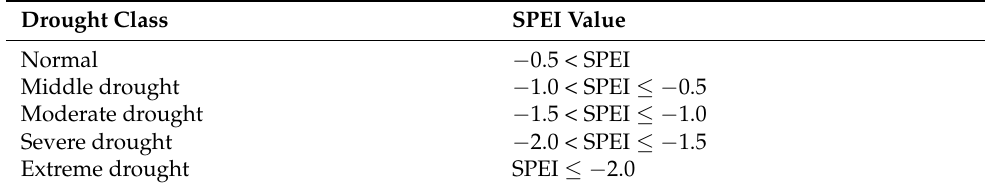
Table 1. Five level classification of drought based on SPEI.